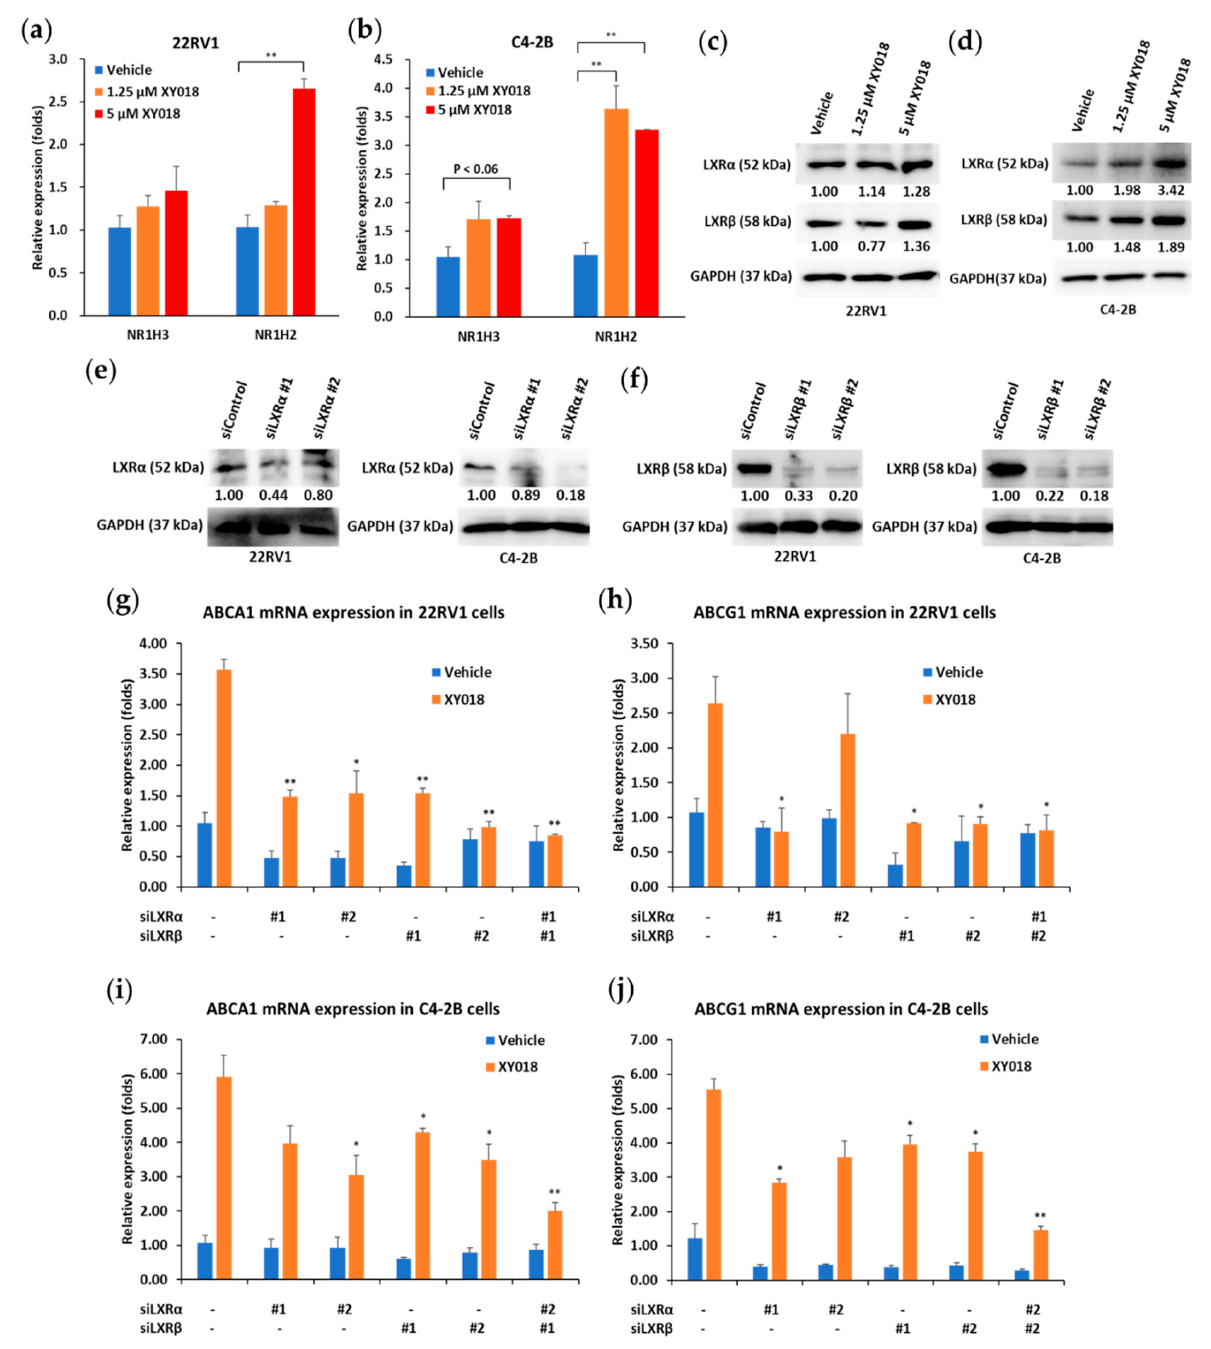
Figure 4. LXR expression regulates aberrant cholesterol efflux gene program mediated by ROR γ in mCRPC cells. ( a , b ) Relative expression of NR1H3 and NR1H2 mRNA in fold changes, as detected by qRT-PCR in 22Rv1 ( a ) and C4-2B ( b ) cells treated with indicated concentrations of XY018 for 48 h. ( c , d ) Immunoblotting of LXR α and LXR β proteins in 22Rv1 ( c ) and C4-2B ( d ) cells treated with indicated concentrations of XY018 for 72 h. ( e , f ) Immunoblotting of LXR α ( e ) and LXR β ( f ) proteins in 22Rv1 and C4-2B cells treated with indicated siRNAs for 48 h. ( g – j ) Relative expression of ABCA1 and ABCG1 mRNA in fold changes, as detected by qRT-PCR in 22Rv1 ( g , h ) and C4-2B ( i , j ) cells treated with vehicle (DMSO) or 2.5 µ M XY018 and indicated siRNAs for 48 h. The experiments were repeated three times. Data are shown as mean ± s.d. n = 3. Student’s t test. * p < 0.05 ** p <